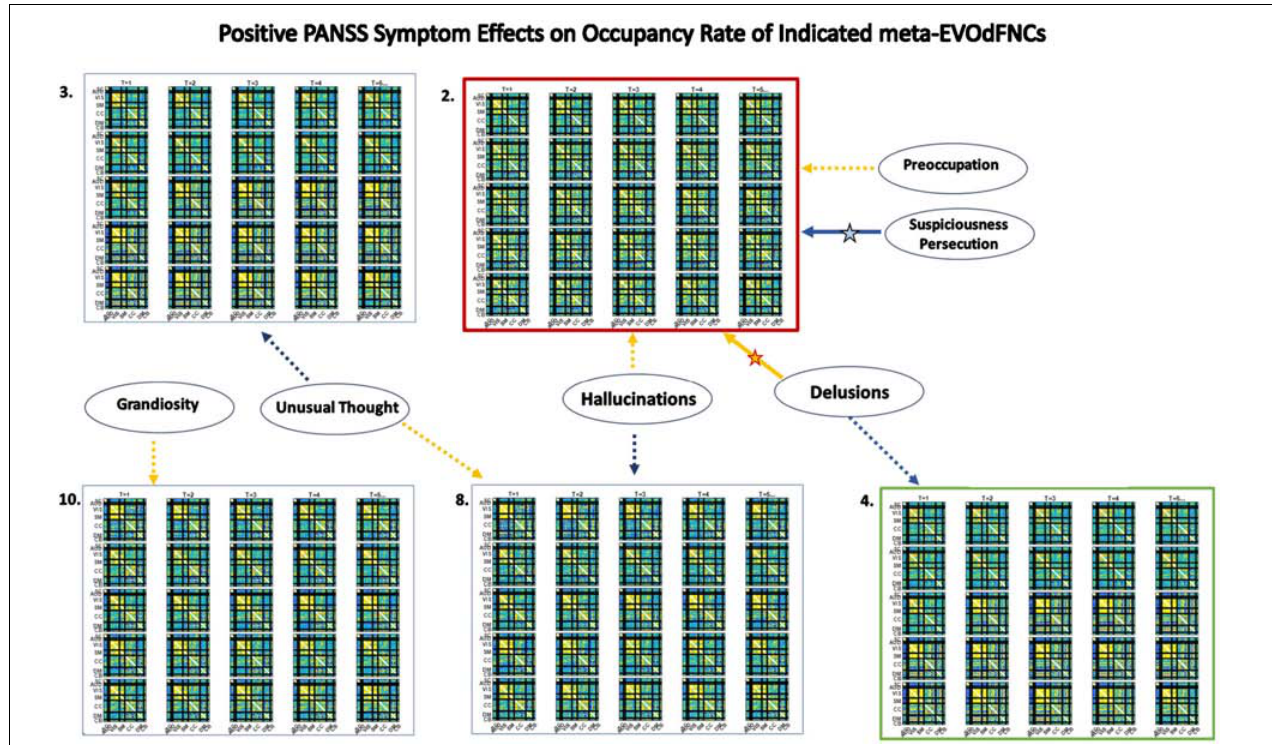
FIGURE 15 | Significant positive symptom effects on the occupancy of meta-EVOdFNCs, each a weighted combination of EVOdFNCs. Thick arrows with stars indicate effects that are significant after correction for multiple comparisons; thin dashed arrows indicate effects that are significant with p < 0 . 05, but not after correction for multiple comparisons. Yellow lines denote positive effects. Blue lines denote negative effects. Consistent with results on representational importance of EVOdFNCs, meta-EVOdFNC 2 which is heavily weighted on EVOdFNC 3 is a locus of positive symptom effects, including positive effects of delusions and negative effects of suspiciousness/persecution that remain significant after correction for multiple comparisons. Note that positive symptoms exhibit no significant ( p < 0.05, uncorrected) effects on the occupancy rates of the